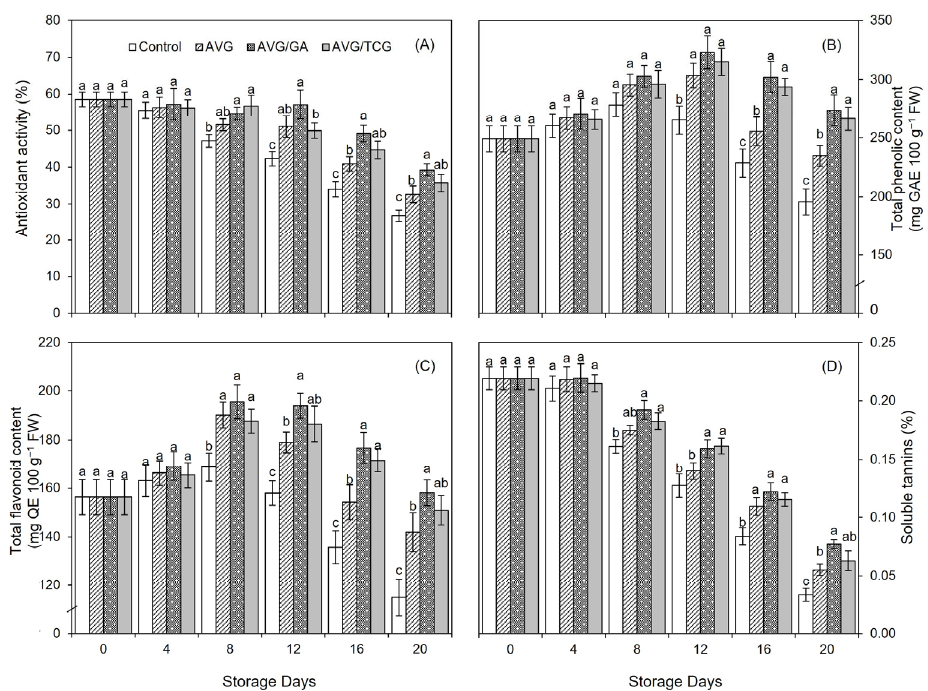
Figure 5. Effect of AVG-based composite coatings on antioxidant activity ( A ), total phenolic content ( B ), total flavonoid content ( C ) and soluble tannins ( D ) of persimmon fruits during 20 days storage (analysis on day 0, 4, 8, 12, 16 and 20) at 20 ± 1 °C and 80–85% relative humidity. All standard error bars are centered on means (3 biological replicates). Graph bars sharing same letters on a storage interval have non ‐ significance difference according to the LSD test at p ≤ 0.05.